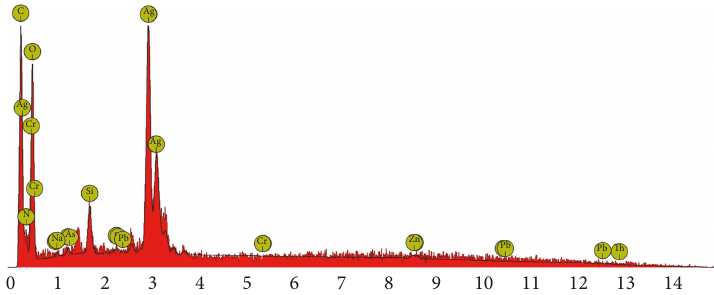
Figure 2: EDS characterisation of the bionanoparticle from the SEM facility.